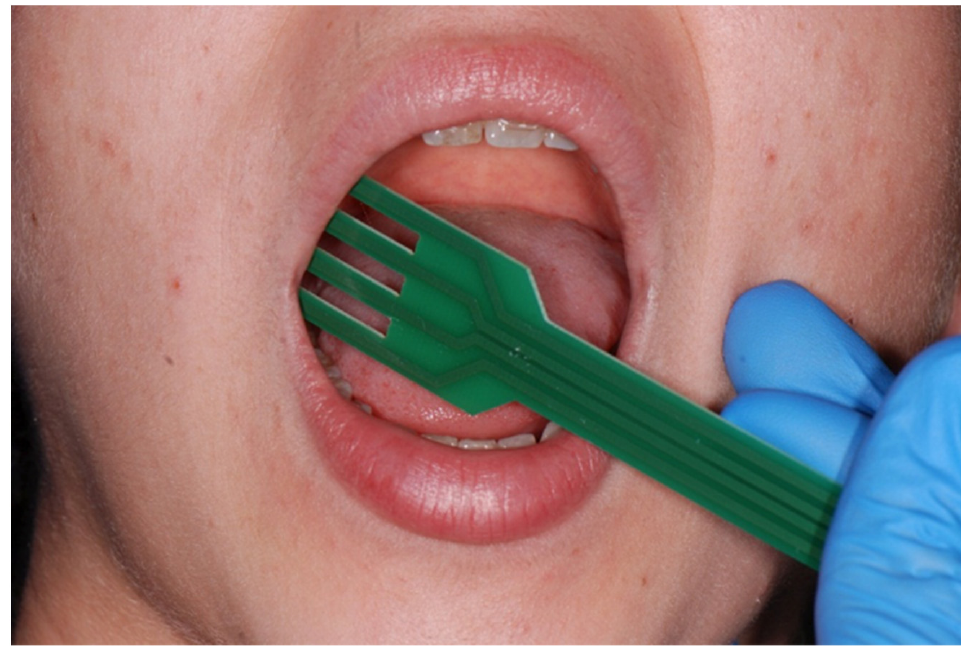
Figure 1. the use of the “fork”. Figure 1. The use of the